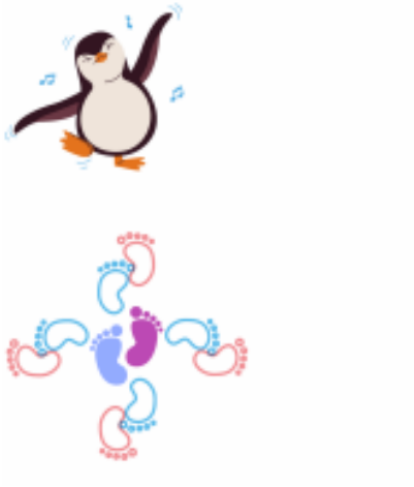
Figure 7. Interface of the game “Let us Dance!”.